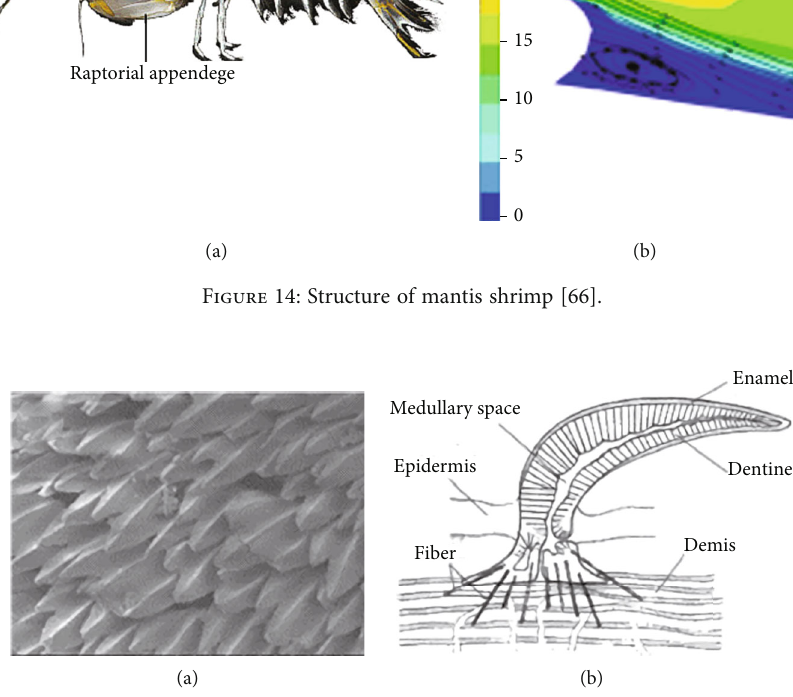
Figure 15: Shark shield scale [76]: (a) shield scale domain of shark skin and (b) shield-scale planning